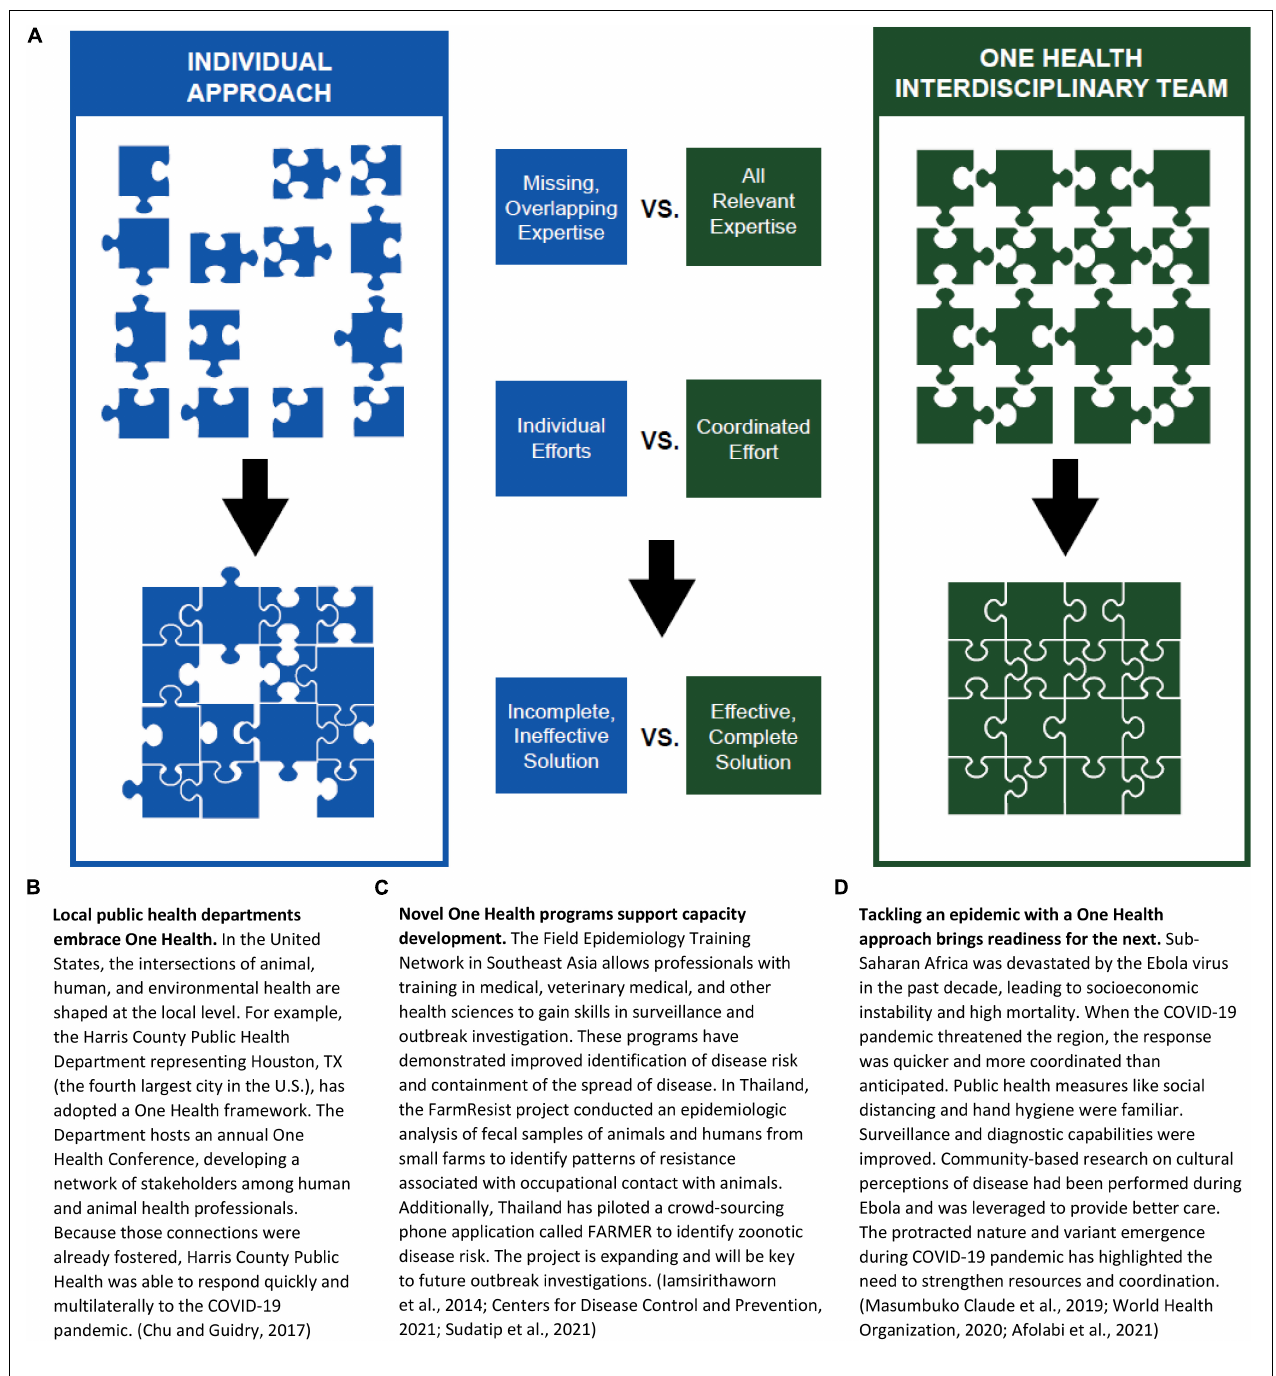
FIGURE 2 | A One Health Approach: Framework and Vignettes. (A) A One Health approach brings together a diverse, inclusive, multidisciplinary team of experts to address complex problems resulting in coordinated, effective, complete solutions. One Health teams incorporate individuals from all science disciplines including but not limited to data, math, computer, engineering, behavioral, social, economic, cultural, natural, applied, biomedical, agricultural, and environmental sciences. Creating a framework for One Health teams with international connections can decrease the challenges and costs associated with multiple individual efforts. (B–D) Vignettes representing a One Health